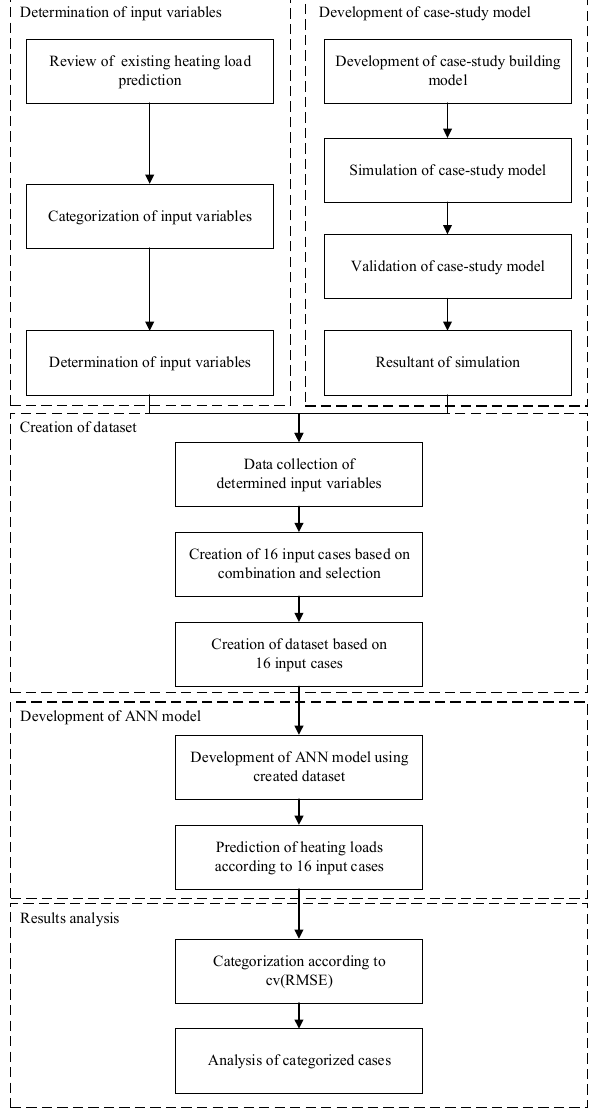
Figure 2. Overall study